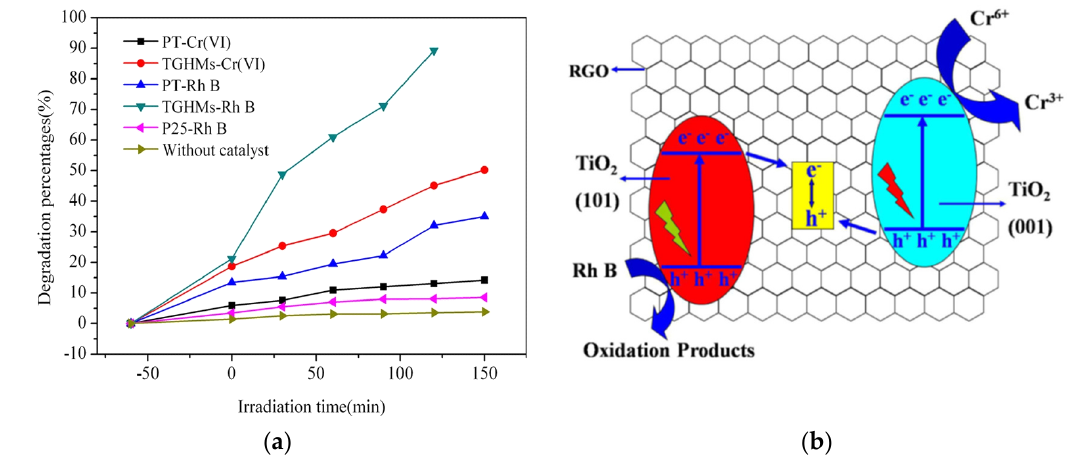
Figure 3. ( a ) Photocatalytic conversion of Cr(VI) and Rh B in single system: TGHMs–graphene-wrapped TiO 2 hollow core-shell microspheres, PT–pure TiO 2 microspheres; ( b ) Schematic graph of proposed mechanism of synergistic removal of Cr(VI) and Rh B in a Z-scheme photocatalytic system consisting of rGO and titania nanocrystals with exposed (001) and (101) facets under stimulated solar light irradiation. Reprinted with permission from [40]. Copyright 2016 Creative Commons Attribution.